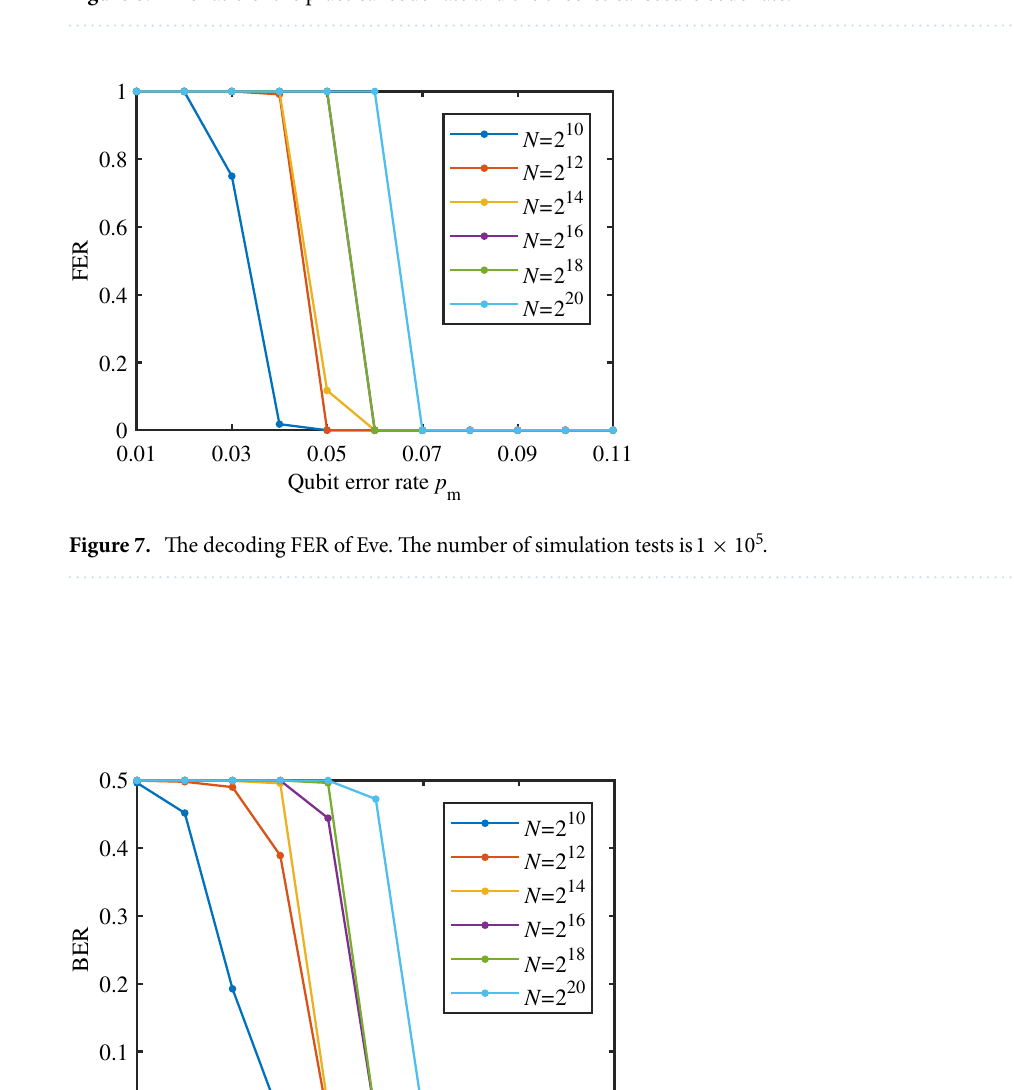
Figure 6. The ratio of the practical code rate and the theoretical secure code rate.